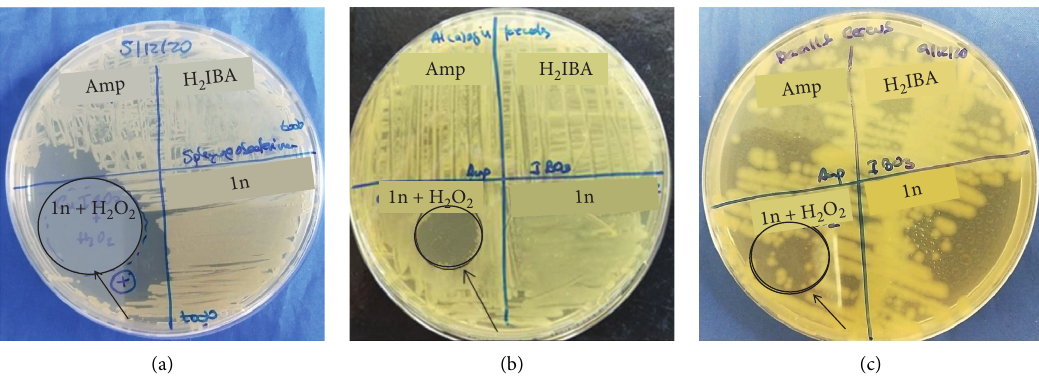
Figure 8: Antibacterial experiments photographs of compound 1n +H tested on. Sphingobacterium (a), Alcaligenes faecalis (b), and Bacillus cereus (c). Ampicillin is used as antibiotic control.